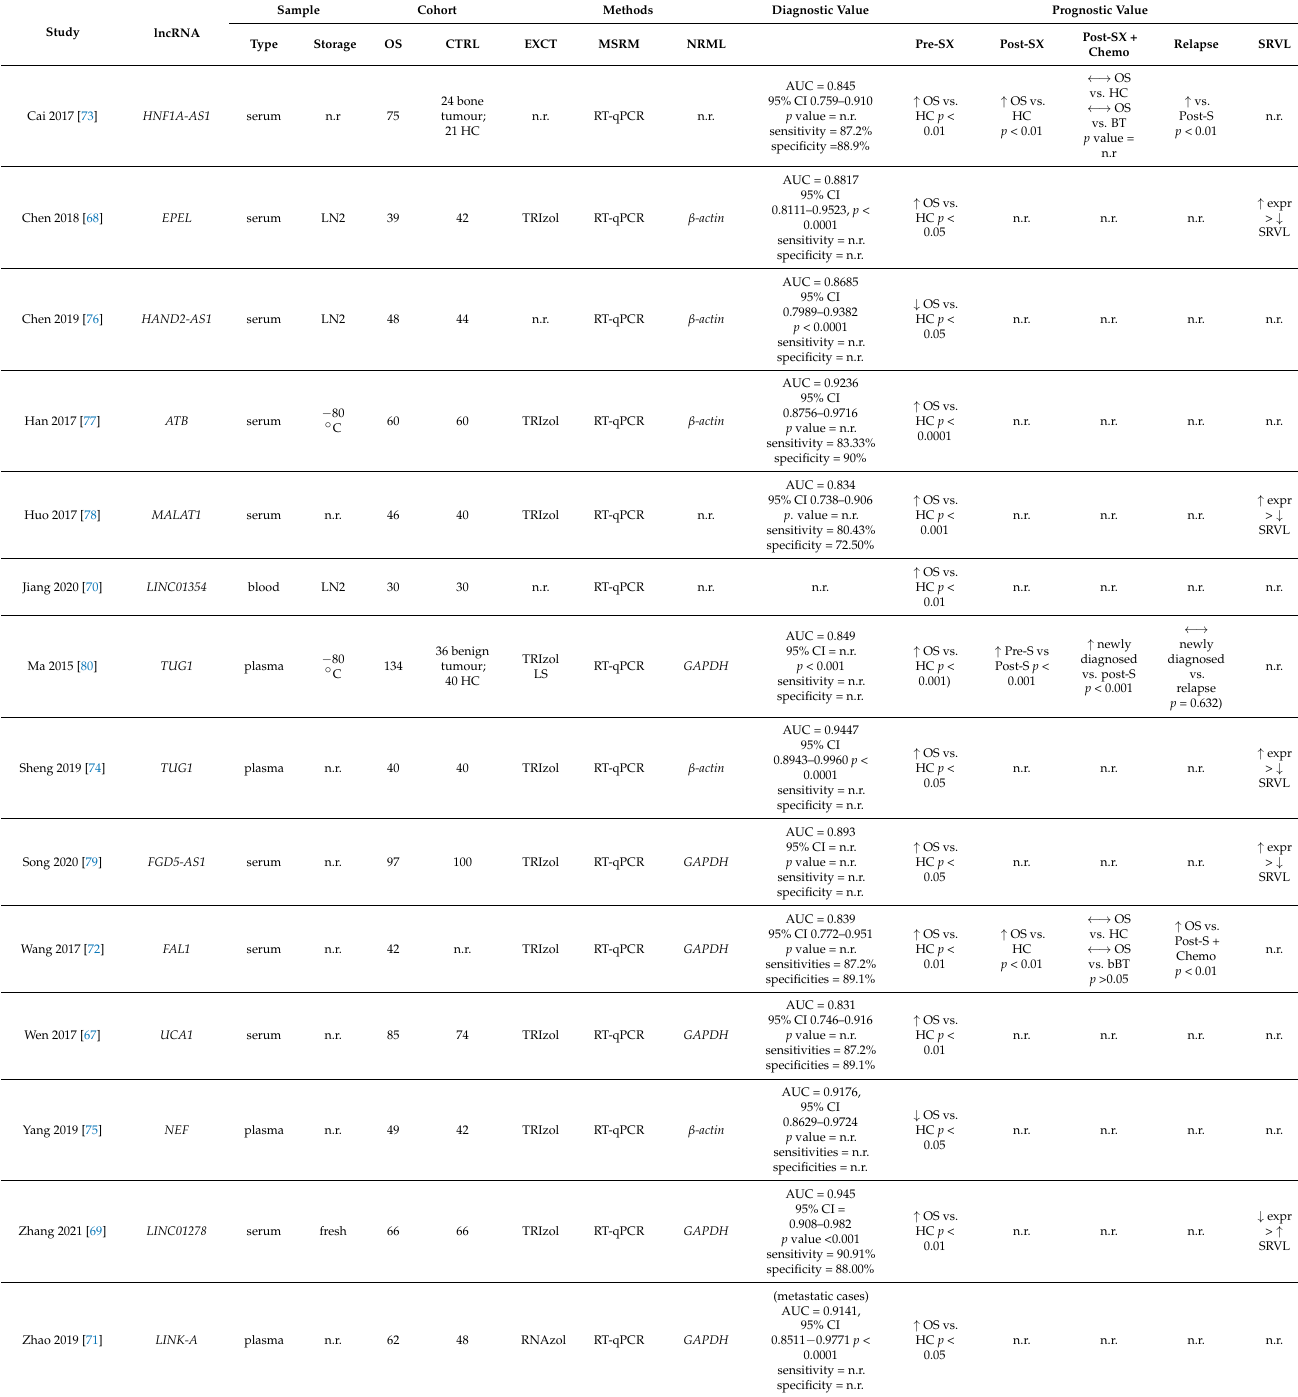
Table 1. Characteristic of the included